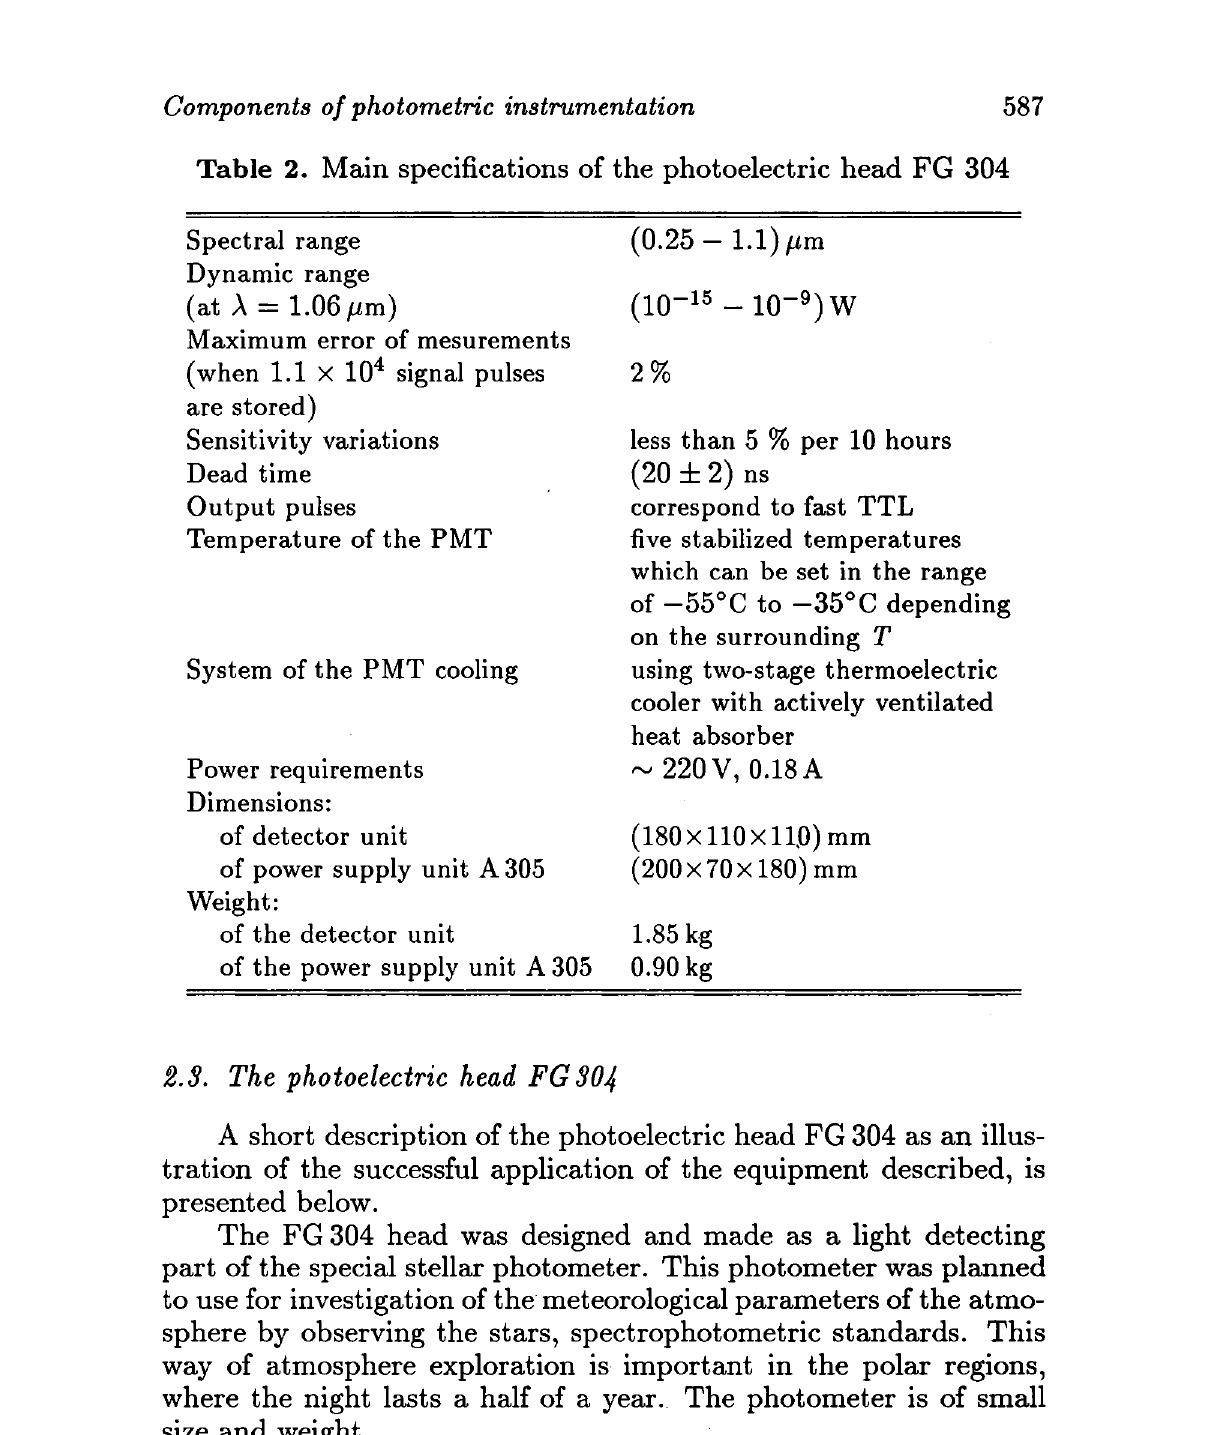
Table 2. Main specifications of the photoelectric head FG 304 Spectral range Dynamic